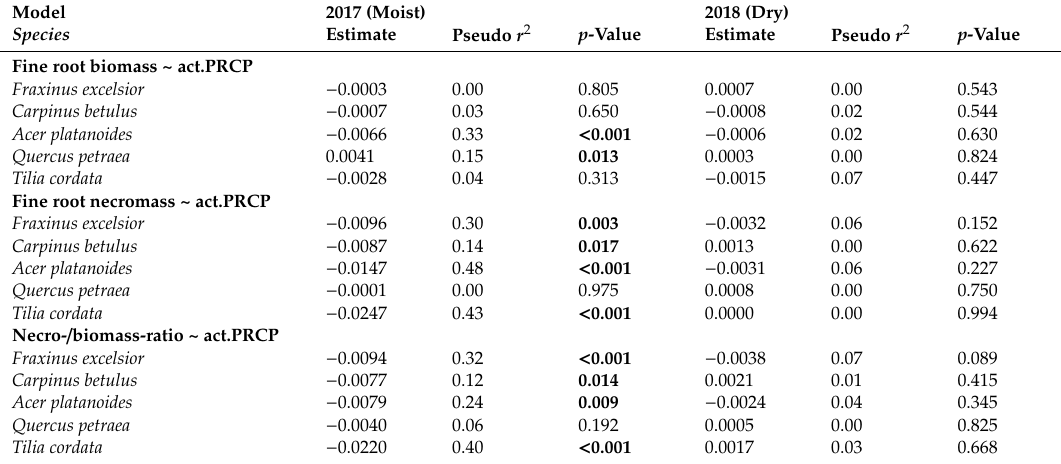
Table A1. Results of linear mixed e ff ects models for fine root bio- and necromass in dependence of actual precipitation in the year prior to sampling (act.PRCP). Given are estimates of the fixed e ff ect (fine root trait ~ species:MAP), marginal pseudo- R 2 for the fixed e ff ect (calculated according to Nakagawa and Schielzeth (2013)), and p -values. p -values below 0.05 are given in bold. All fine root traits